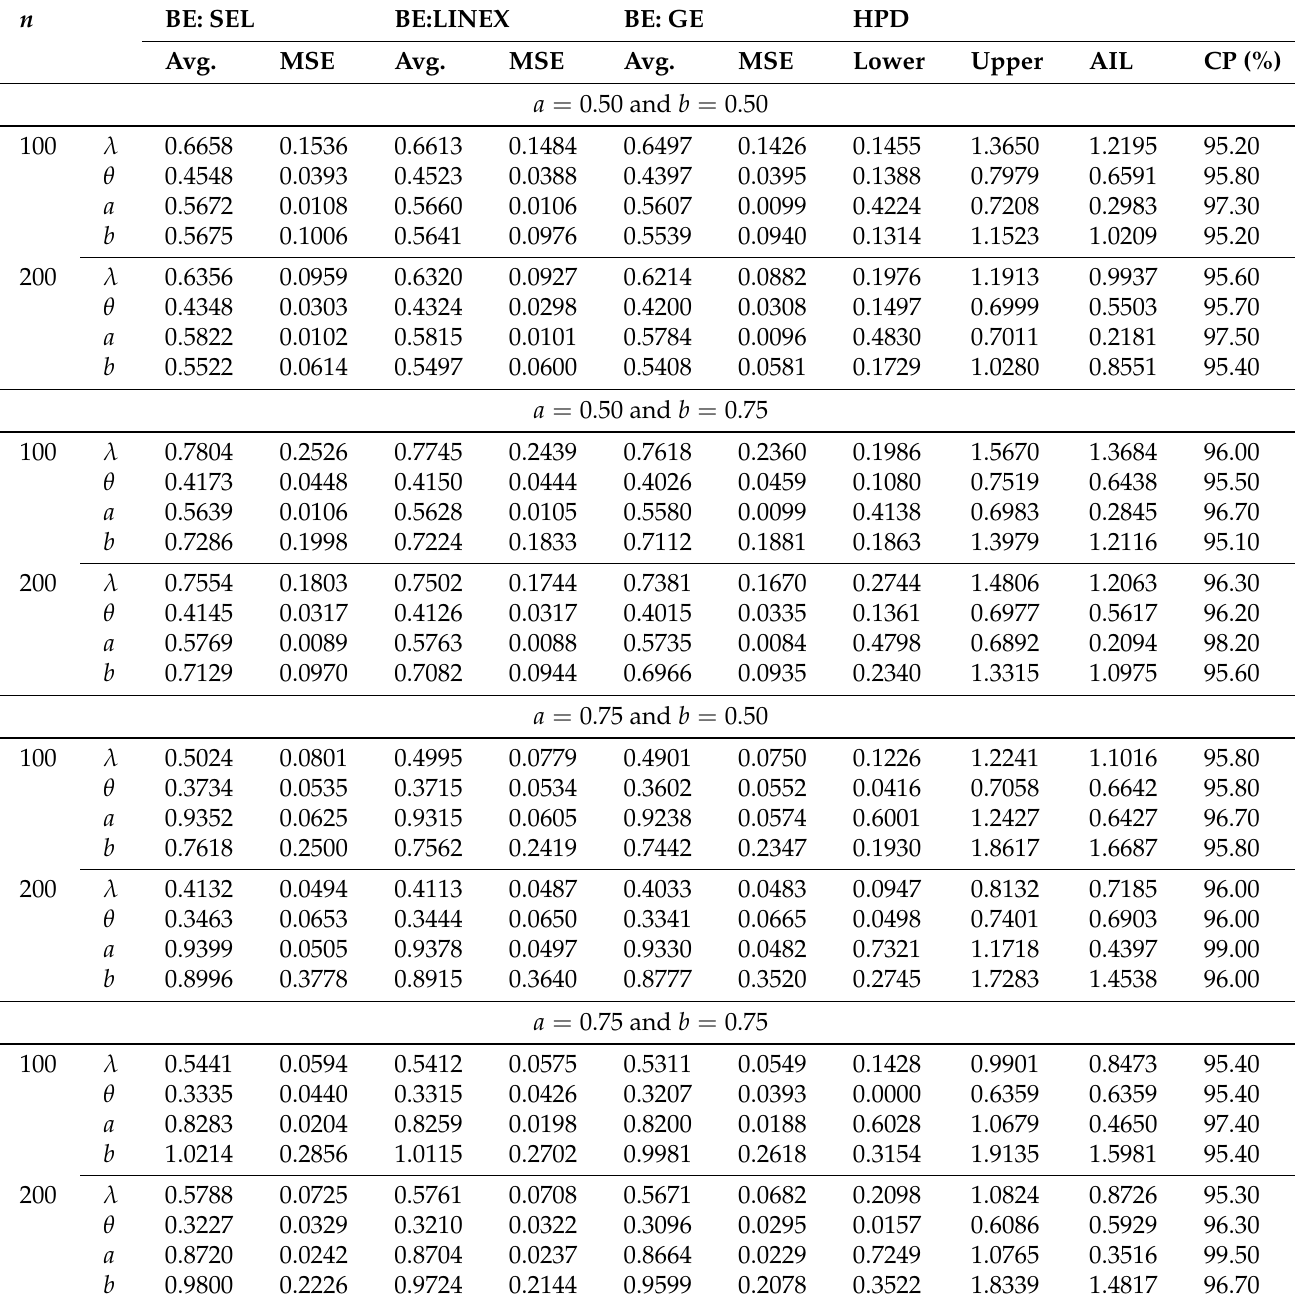
Table 10. Avg. estimated values and MSEs of the BE using MCMC for the BBE 2 distribution